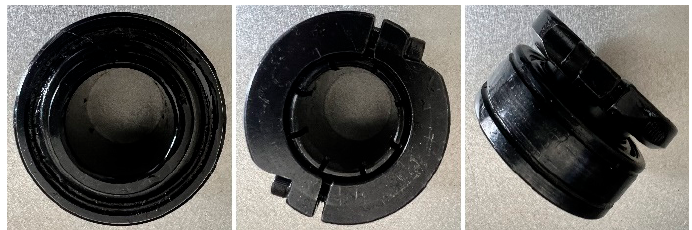
Figure 6. Diagnostic results of different models for the bearing datasets.